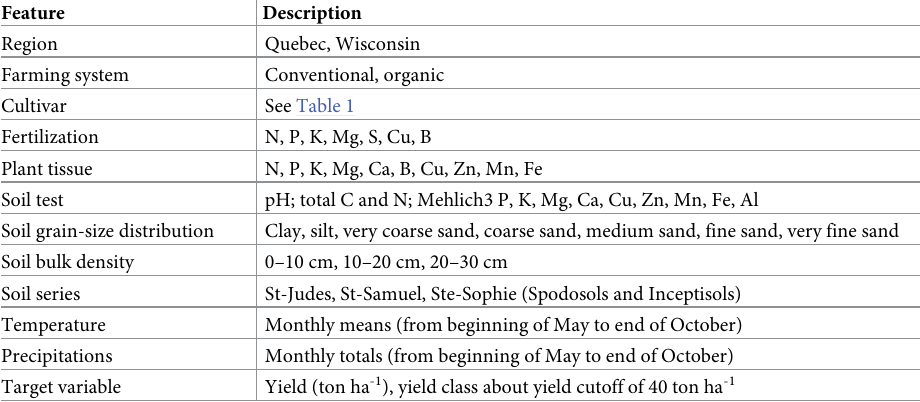
Table 2. Features and target variables in the Quebec-Wisconsin